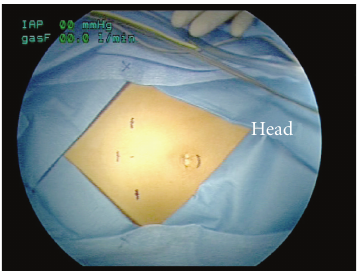
Figure 1: Port placement.